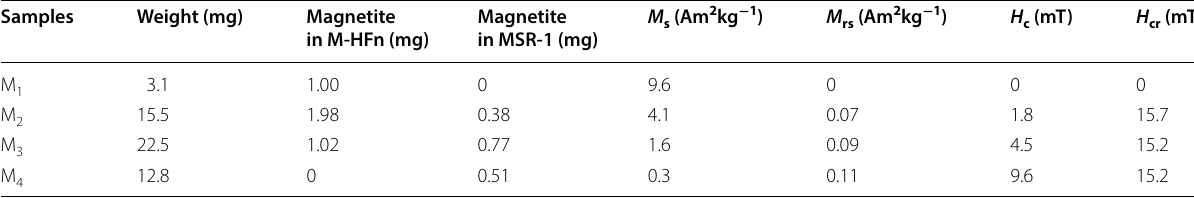
M s , saturation magnetization; M rs , saturation remanence; H c , coercivity force; H cr , remanence coercivity Calculation of magnetite mass in magnetoferritin (M-HFn)